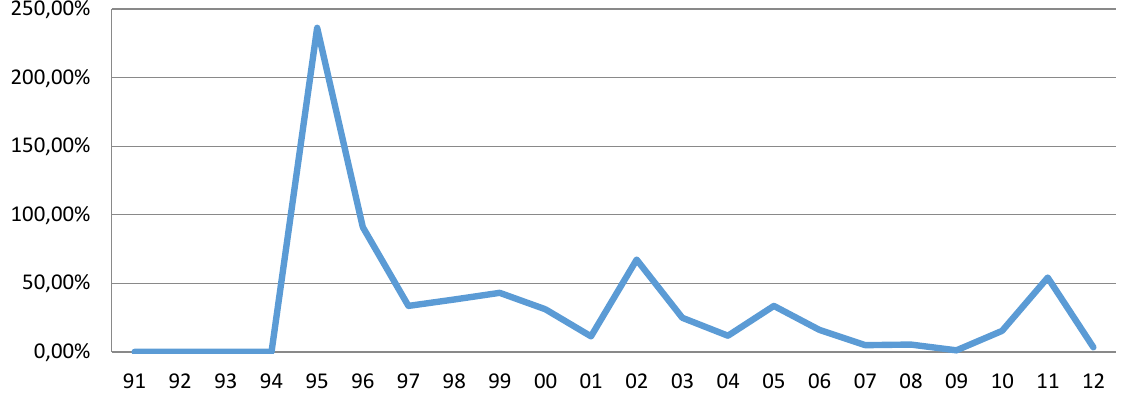
Figure 4. Indicator C12: Mean year-on-year rate of variation